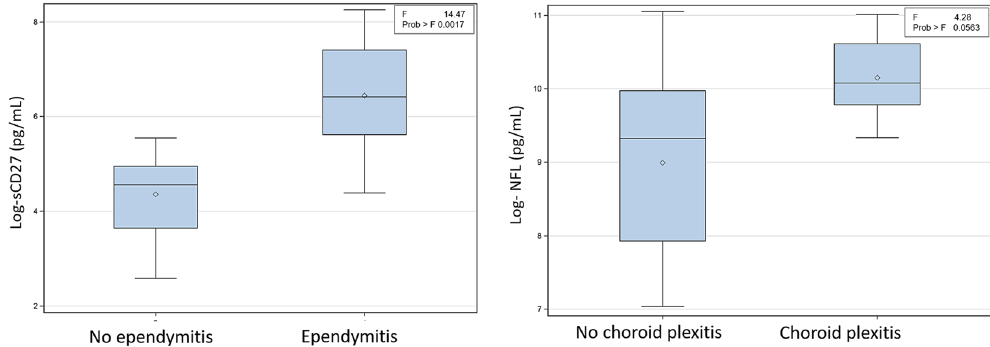
Figure 4. Box plots showing the distribution of log(sCD27) with respect to the presence of ependymitis and log(NFL) with respect to the presence of choroid